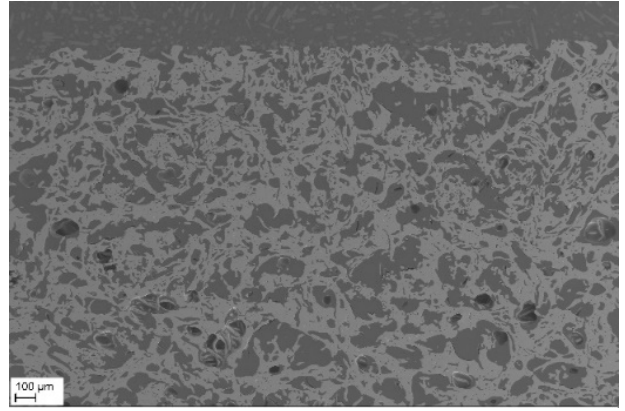
Figure 10. SEM cross-section of a Ce 0.85 Zr 0.13 Y 0.02 O 1.99 felt after 1923 K (2 h).